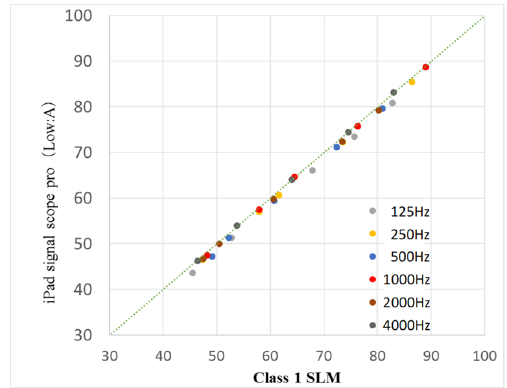
Figure 4. Example of accuracy result of equivalent sound level (LAeq) measuring application (Signal Scope Pro 7 on iPad) compared with a class 1 sound level meter (SLM) [13].